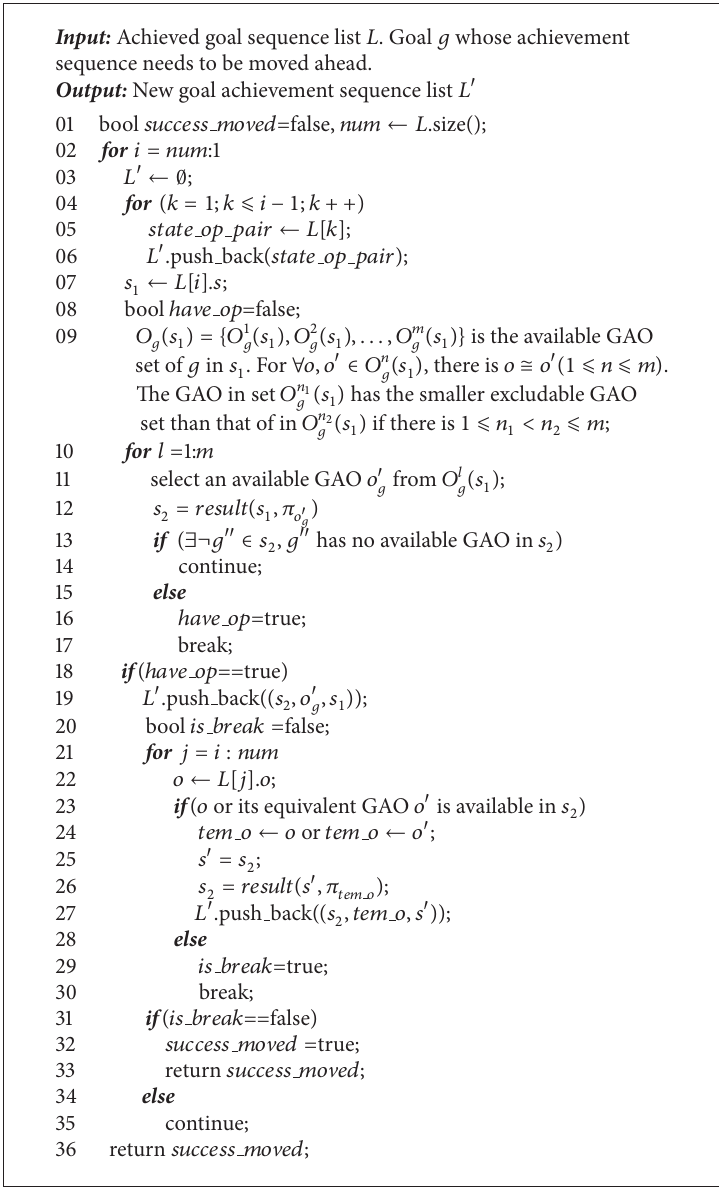
Algorithm 2: 𝑀𝑜 V 𝑒 𝑎ℎ𝑒𝑎𝑑(𝐿,𝑔, 𝐿 󸀠 )